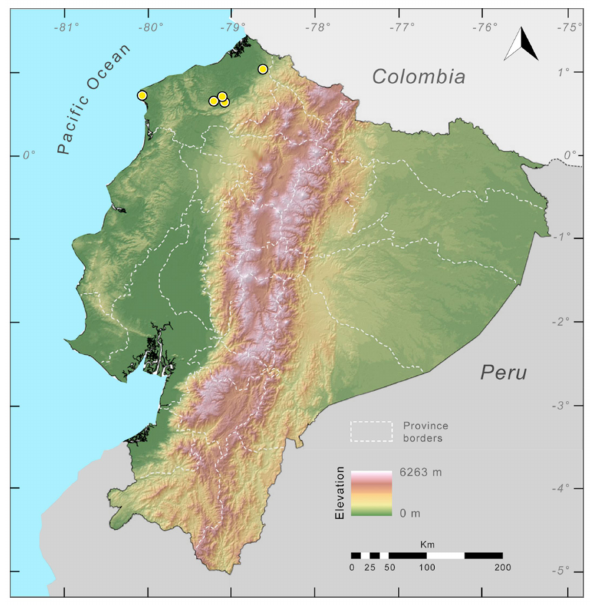
Figure 108. Distribution of Hyalinobatrachium chirripoi in Ecuador (yellow